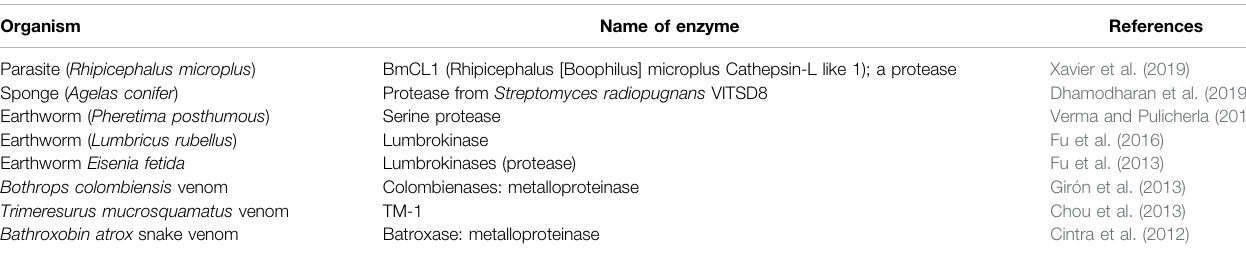
TABLE 6 | Fibrinolytic enzymes obtained from non-microbial sources.